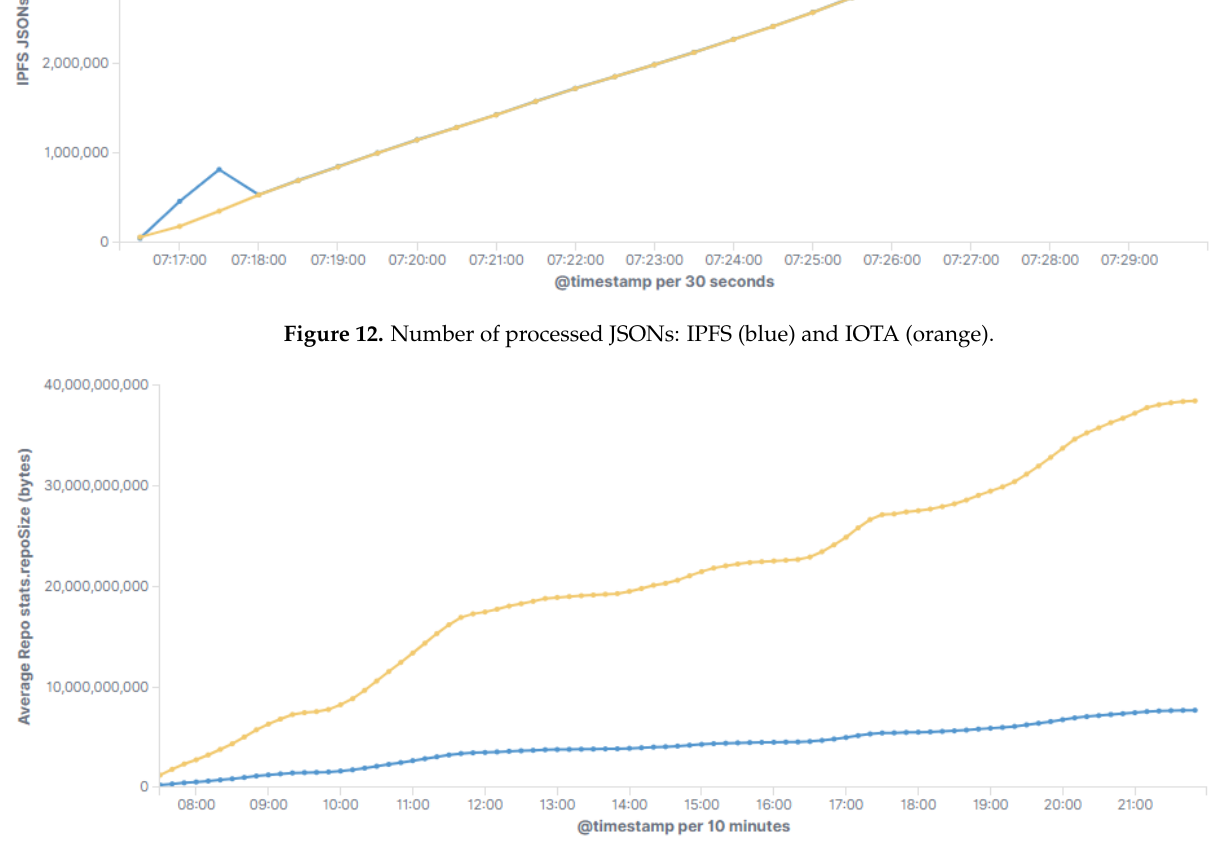
Figure 13. Comparison in bytes between storage in IPFS (blue) and IOTA (orange).